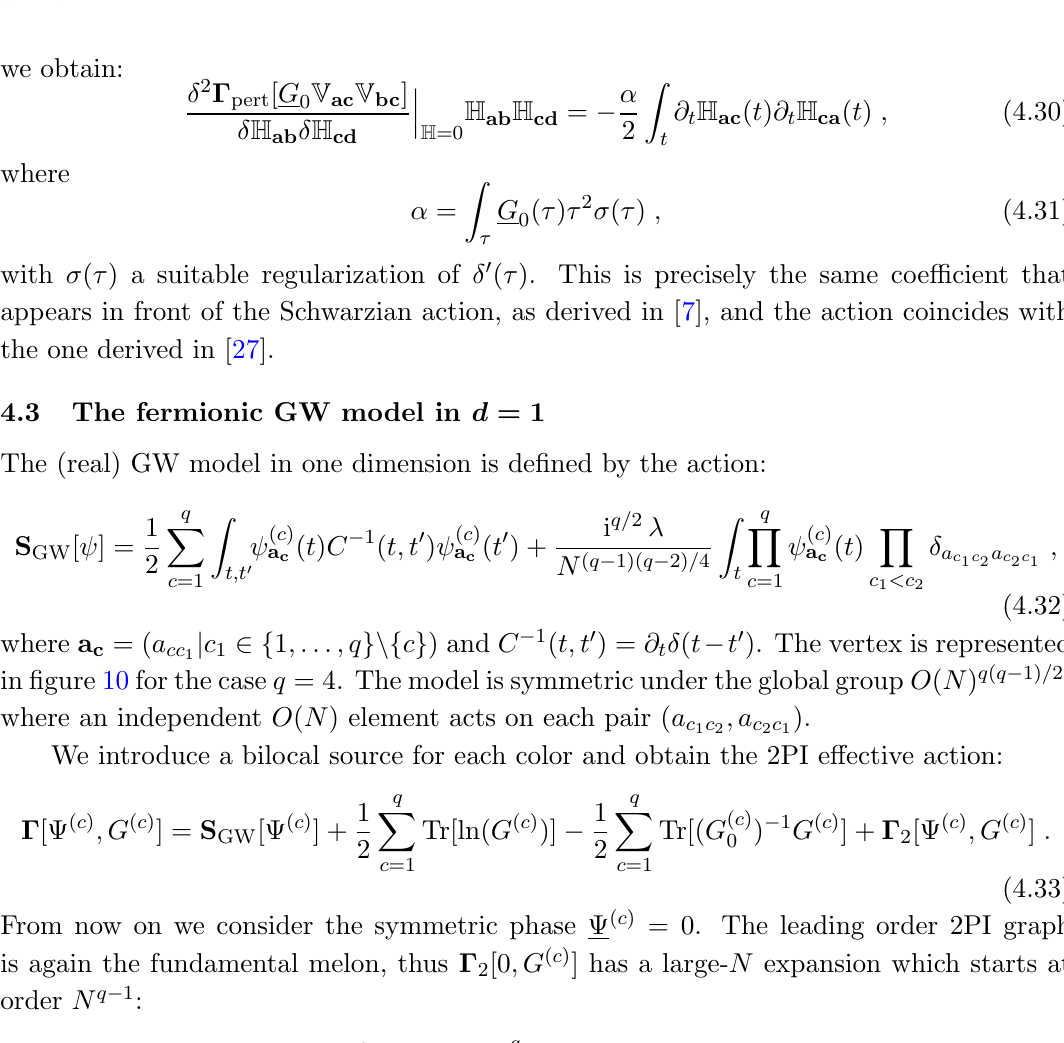
Figure 10 . The vertex of the GW model (4.32) with q = 4 in the Feynman (left) and the stranded (right)